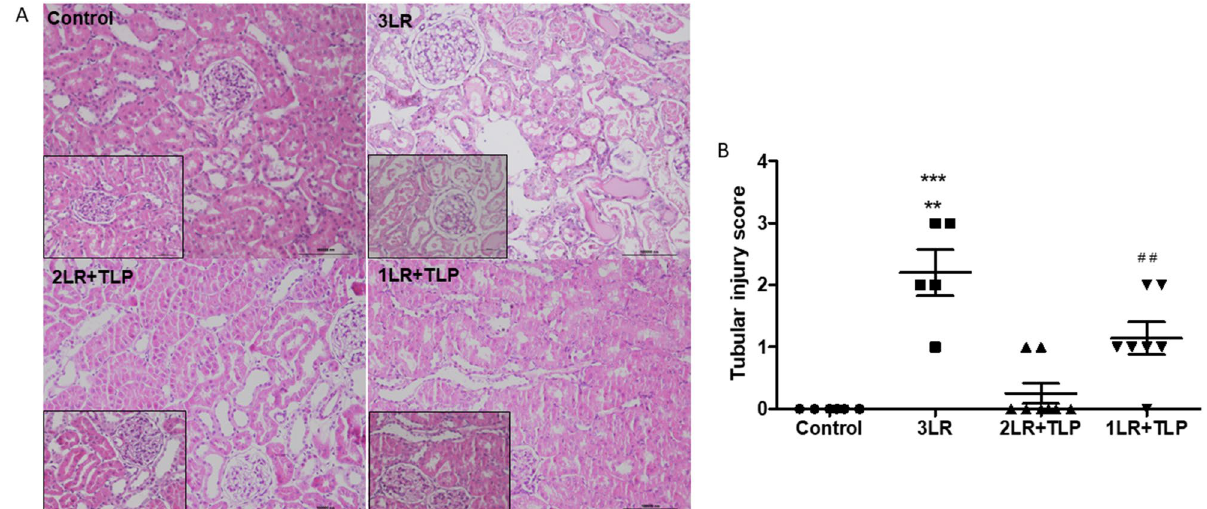
Figure 4. Acute tubular injury at 24 h after hemorrhagic shock induction. Kidney tissue sections stained with periodic acid-Schiff (A). Magnification, × 200 and × 400. Tubular damage score measured in the cortex (B). *** P < 0.001 vs. control and 2LR + TLP; ** P < 0.01 vs. 1LR + TLP; ## P < 0.01 vs. control and 2LR + TLP; Control, no intervention; 3LR, induction of hemorrhagic shock, followed by infusion of lactated Ringer’s at 3 times the volume of the blood withdrawn; 2LR + TLP, induction of hemorrhagic shock, followed by infusion of lactated Ringer’s at 2 times the volume of the blood withdrawn, together with intravenous injection of terlipressin at 10 µg/100 g body weight; 1LR + TLP, induction of hemorrhagic shock, followed by infusion of lactated Ringer’s at a volume equal to that of the blood withdrawn, together with intravenous injection of terlipressin at 10 µg/100 g body weight.